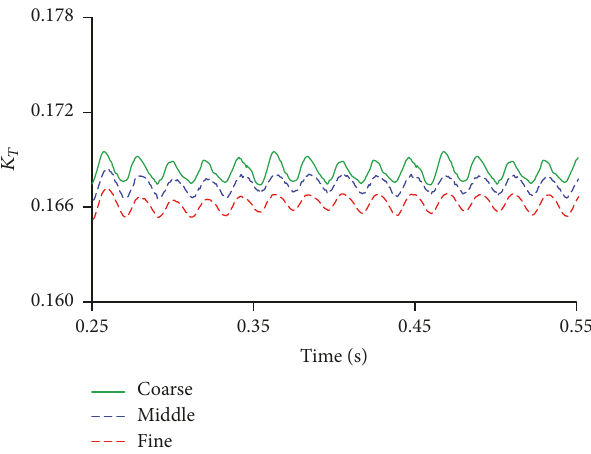
Figure 23: Grid refinement study based on the predicted fluctuating thrust. Table 7: Validation of the numerical methods for propeller simula- tion under nonuniform wake.